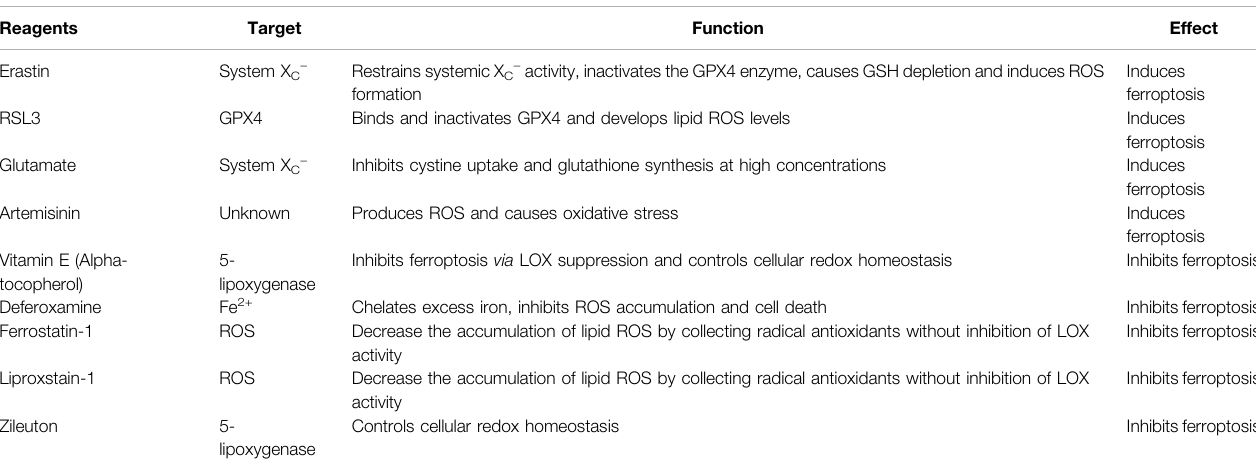
TABLE 2 | Ferroptosis inducers and